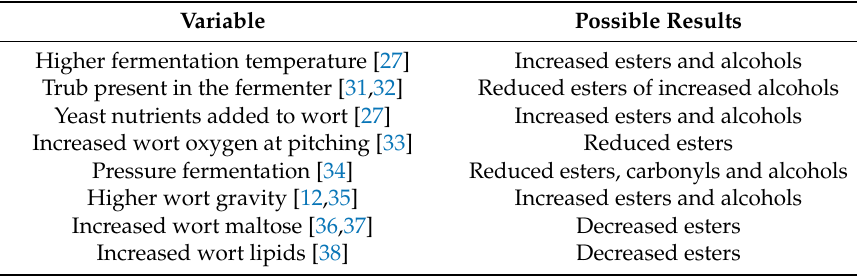
Table 2. Effects of process variables on beer ester and higher alcohol levels.